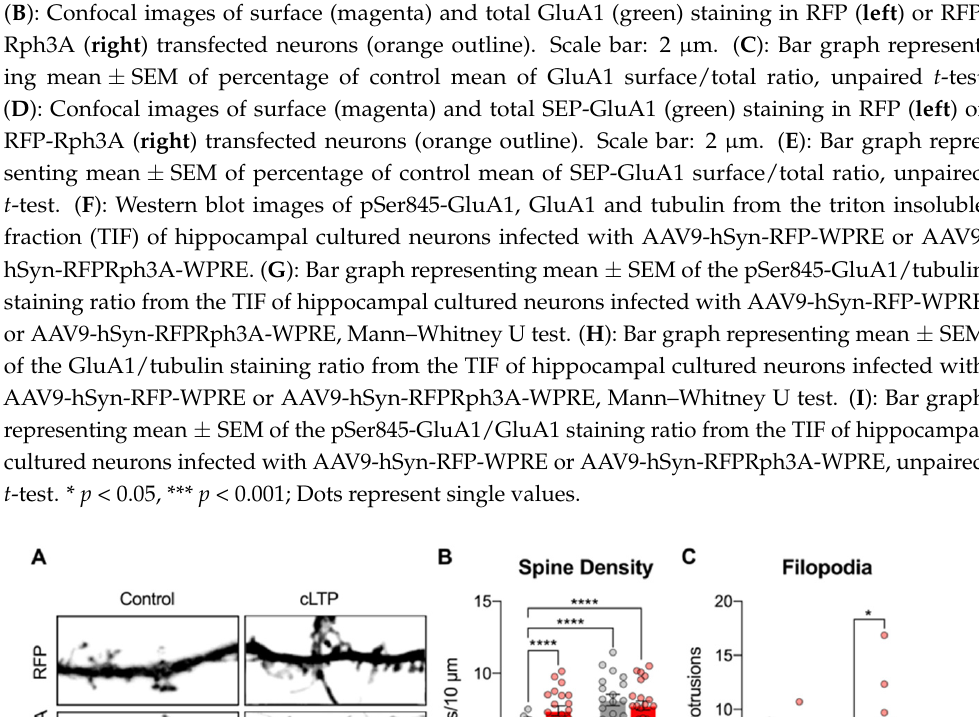
( B ): Confocal images of surface (magenta) and total GluA1 (green) staining in RFP ( left ) or RFP- Rph3A ( right ) transfected neurons (orange outline). Scale bar: 2 µ m. ( C ): Bar graph represent- ing mean ± SEM of percentage of control mean of GluA1 surface/total ratio, unpaired t -test. ( D ): Confocal images of surface (magenta) and total SEP-GluA1 (green) staining in RFP ( left ) or RFP-Rph3A ( right ) transfected neurons (orange outline). Scale bar: 2 µ m. ( E ): Bar graph repre- senting mean ± SEM of percentage of control mean of SEP-GluA1 surface/total ratio, unpaired t -test. ( F ): Western blot images of pSer845-GluA1, GluA1 and tubulin from the triton insoluble fraction (TIF) of hippocampal cultured neurons infected with AAV9-hSyn-RFP-WPRE or AAV9- hSyn-RFPRph3A-WPRE. ( G ): Bar graph representing mean ± SEM of the pSer845-GluA1/tubulin staining ratio from the TIF of hippocampal cultured neurons infected with AAV9-hSyn-RFP-WPRE or AAV9-hSyn-RFPRph3A-WPRE, Mann–Whitney U test. ( H ): Bar graph representing mean ± SEM